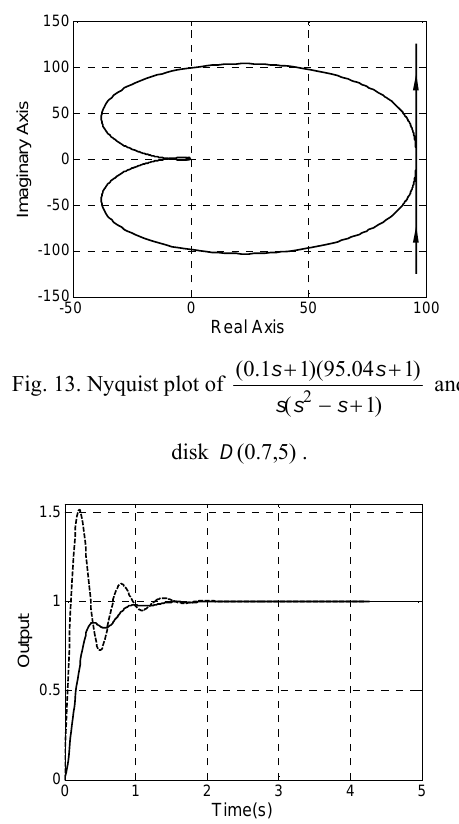
T-S PI fuzzy controller (solid line) and traditional PI controller (dash line).